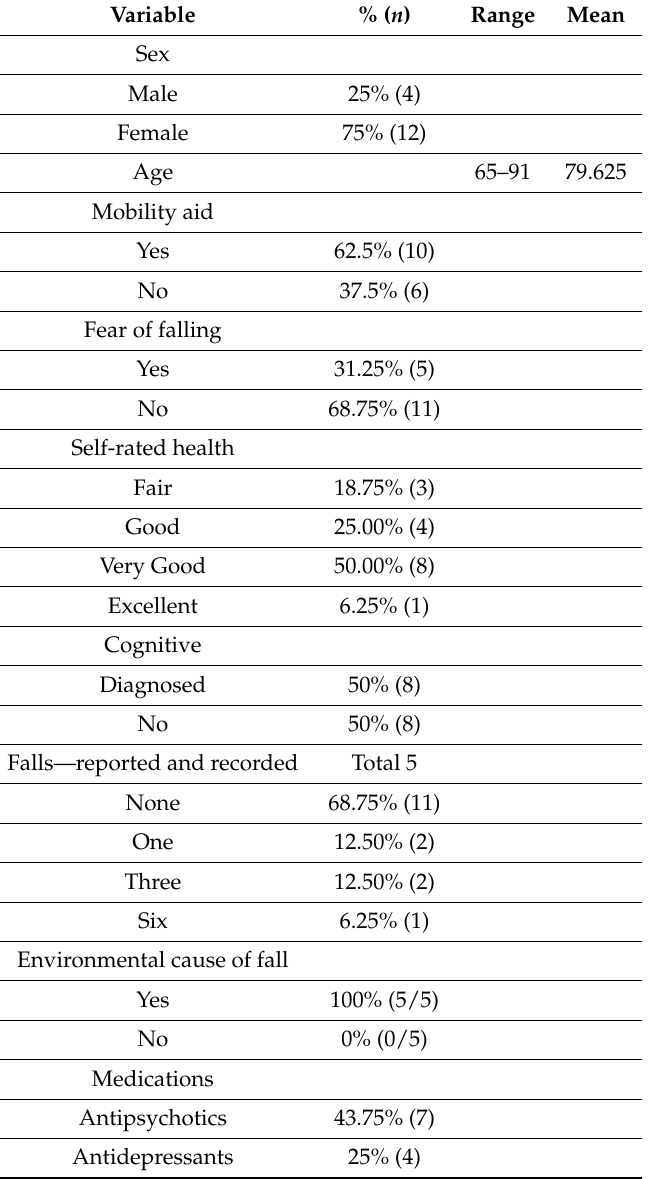
Table 3. Descriptive statistics. n =